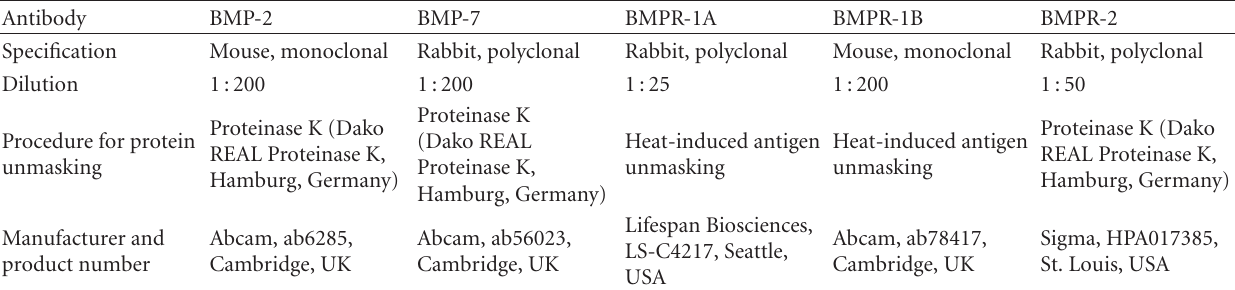
Table 1: Specification of the used antibodies for